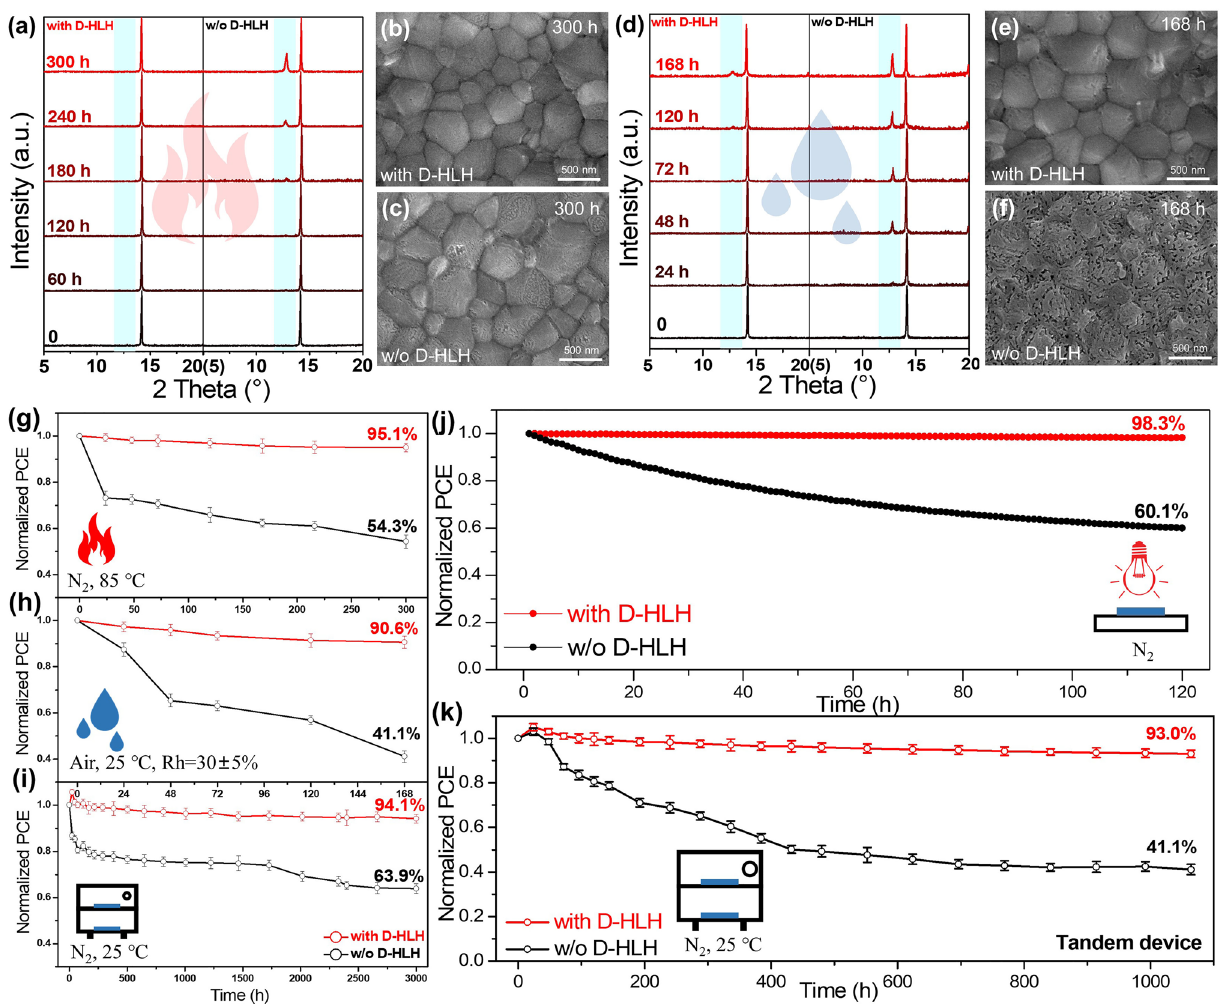
Fig. 6 a–c, g Thermal stability measurements: a XRD spectra of perovskite films prepared with or without D‑HLH; b, c SEM images of per‑ ovskite films prepared b with and c without D‑HLH; and g normalized PCEs of PSC prepared with and without D‑HLH. d–f, h Humidity stabil‑ ity measurements: d XRD spectra of perovskite films prepared with and without D‑HLH; e, f SEM images of perovskite films prepared e with and f without D‑HLH; and h normalized PCEs of PSCs prepared with and without D‑HLH. i, k Shelf stability of i single and k tandem devices prepared with and without D‑HLH. j MPP tracking of unencapsulated single devices prepared with and without D‑HLH treatment, measured in a N 2 glove box under 1‑sun AM 1.5G illumination. The initial PCEs of the single devices prepared with and without D‑HLH treatment were 21.15% and 13.68%,